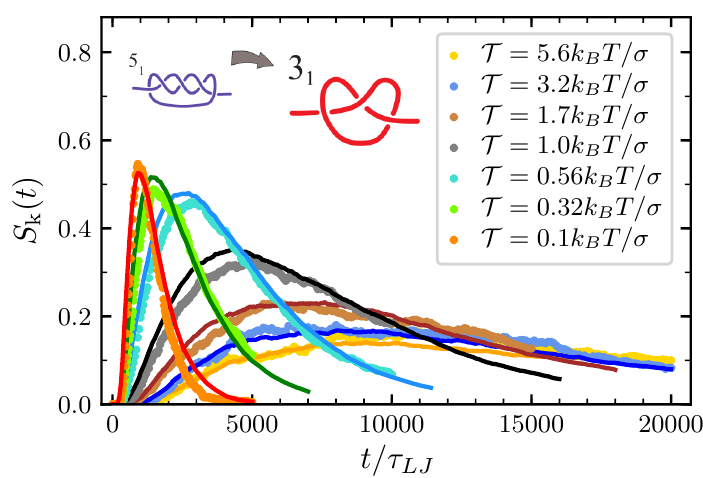
Figure 8. Probability to have a trefoil knot after the decay 5 1